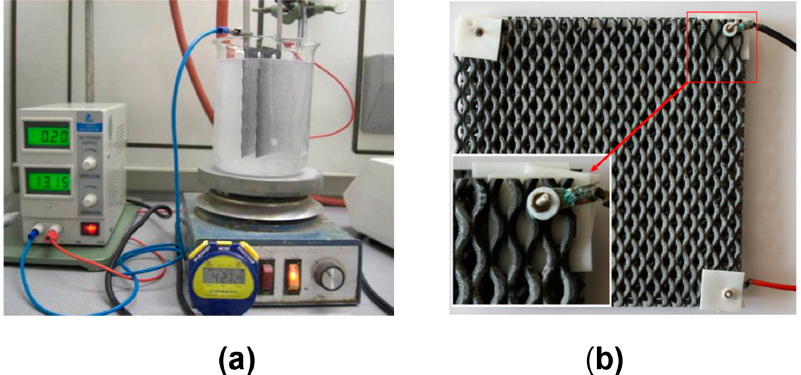
Figure 4. ( a ) The experimental setup shows the BDD / Nb electrode with DC power supply and ( b ) a photograph of the BDD / Nb electrodes for the deposited BDD thin layer on the niobium mesh substrate. The voltage (V), current (A), conductivity ( µ S / cm), acidity (pH), sample temperature ( ◦ temperature ( C), and accumulative time (Min.) were the primary parameters monitored during